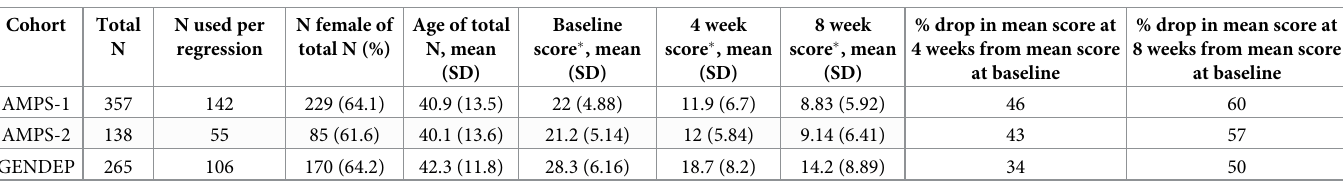
Table 1. Demographic and clinical characteristics.